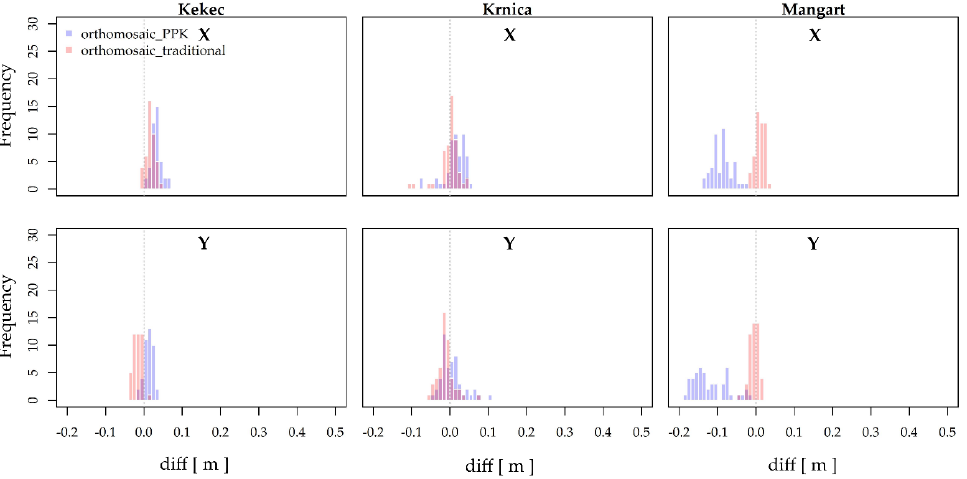
Figure 7. Frequency distribution of the X and Y coordinate differences at all three rockfall sites for orthomosaic_traditional (produced by BBA_traditional) and orthomosaic_PPK (produced by BBA_PPK). Bar width is set to 0.01 m.